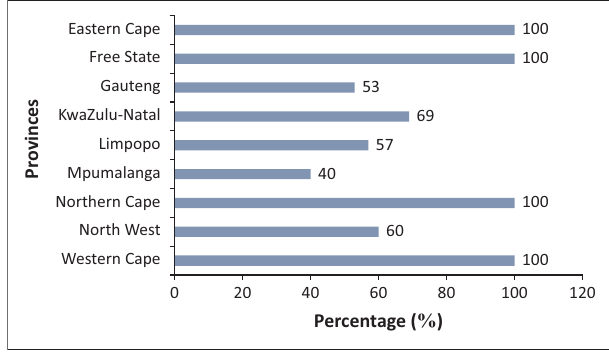
FIGURE 2: Survey completion rate per province ( N =